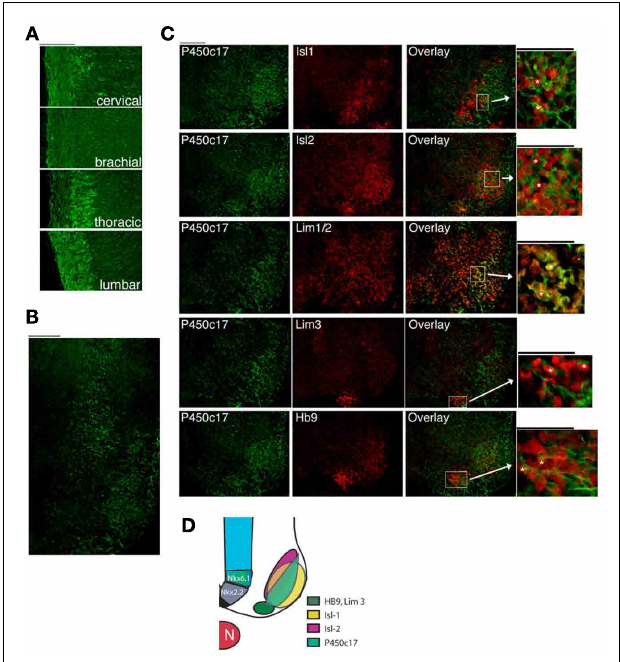
FIGURE 1 | P450c17 expression in the developing spinal cord in the mouse. (A) Immunostaining of P450c17 in E13.5 sagittal sections of the spinal cord. (B) Co-expression of P450c17 (green) with Isl-1, Isl2, Lim1/2, Lim3, and HB9 (red) in an E13.5 transverse section of whole embryo (thoracic level of the spinal cord). For each marker, an overlay with P450c17 is shown, as well as a high magnification view. P450c17 being a microsomal protein, its staining is found both in cell bodies and in fibers, whereas Isl-1, Isl2, Lim1/2, Lim3, and HB9 are nuclear proteins. Asterisks indicate cells dually labeled. (A–C) Bars equal 100 μ m. (D) Schematic representation of the expression domains of P450c17 in the different domains of motor neuron subtypes